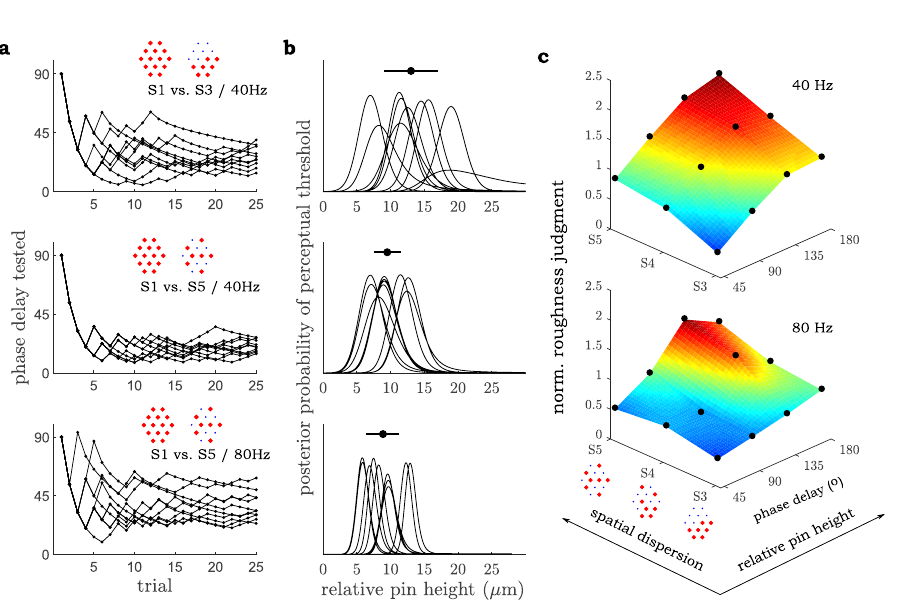
Figure 3. Results from Experiments 2 and 3. ( a ) Adaptive threshold measurements of pin phase for all subjects. ( b ) Posterior distributions of possible threshold values of relative displacement. Solid circles represent the mean of the peak location of each posterior distribution, and the horizontal line represents the associated standard deviation. ( c ) The effect of phasing of two pin groups and the dispersion of pins within these groups on perceived